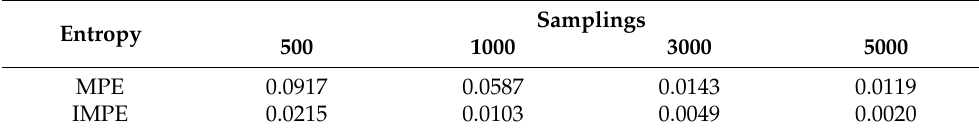
monitor temperature synchronously.